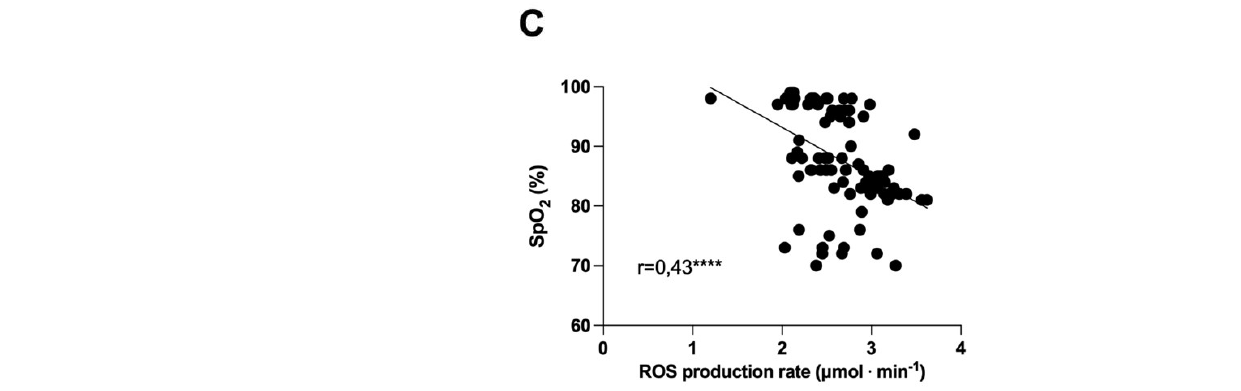
Figure 1. ( A ) Time course of the ROS production rate (μmol·min −1 ) assessed by EPR technique and ( B ) SpO 2 (%) during the transition from normoxia to acute normobaric hypoxia and back to normoxia during recovery. EXP group: full symbols are the data obtained before (0 min) and 15, 30, 45 min after hypoxia exposure (recovery); open symbols are the data during hypoxia status: at 5, 15, 30, 60, 120, 180, 240 min. Green symbols are the data obtained from the CTR (room air, normoxia state FiO 2 = 0.21) for ROS (μmol·min −1 ) and SpO 2 (%). In the inset at the right bottom of Figure A, the exponential fit of the on-transient kinetics data (t 1/2 = 30.02 min, r 2 = 0.995) is shown. Results are expressed as mean ±SD. ( C ) Data (full symbols) and linear correlation line (continuous line, r = 0.43) of the ROS production rate versus SpO 2 . Changes over time were significantly different when com- pared to pre-exposure levels (* p < 0.05; ** p < 0.01; *** p < 0.001; **** p < 0.0001 symbols).